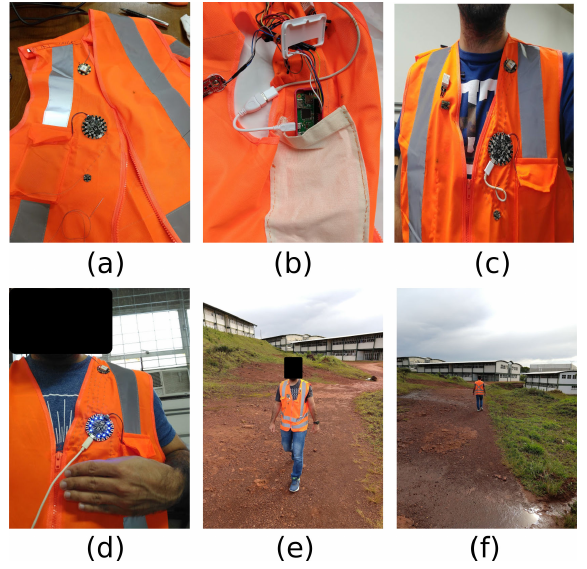
Figure 6. Wearable prototype for surface mining environments: ( a ) prototype during its development. ( b ) Prototype internal pocket holding Raspberry Pi Zero W platform. ( c,d ) In-lab development tests. ( e,f ) Prototype deployment, field tests and